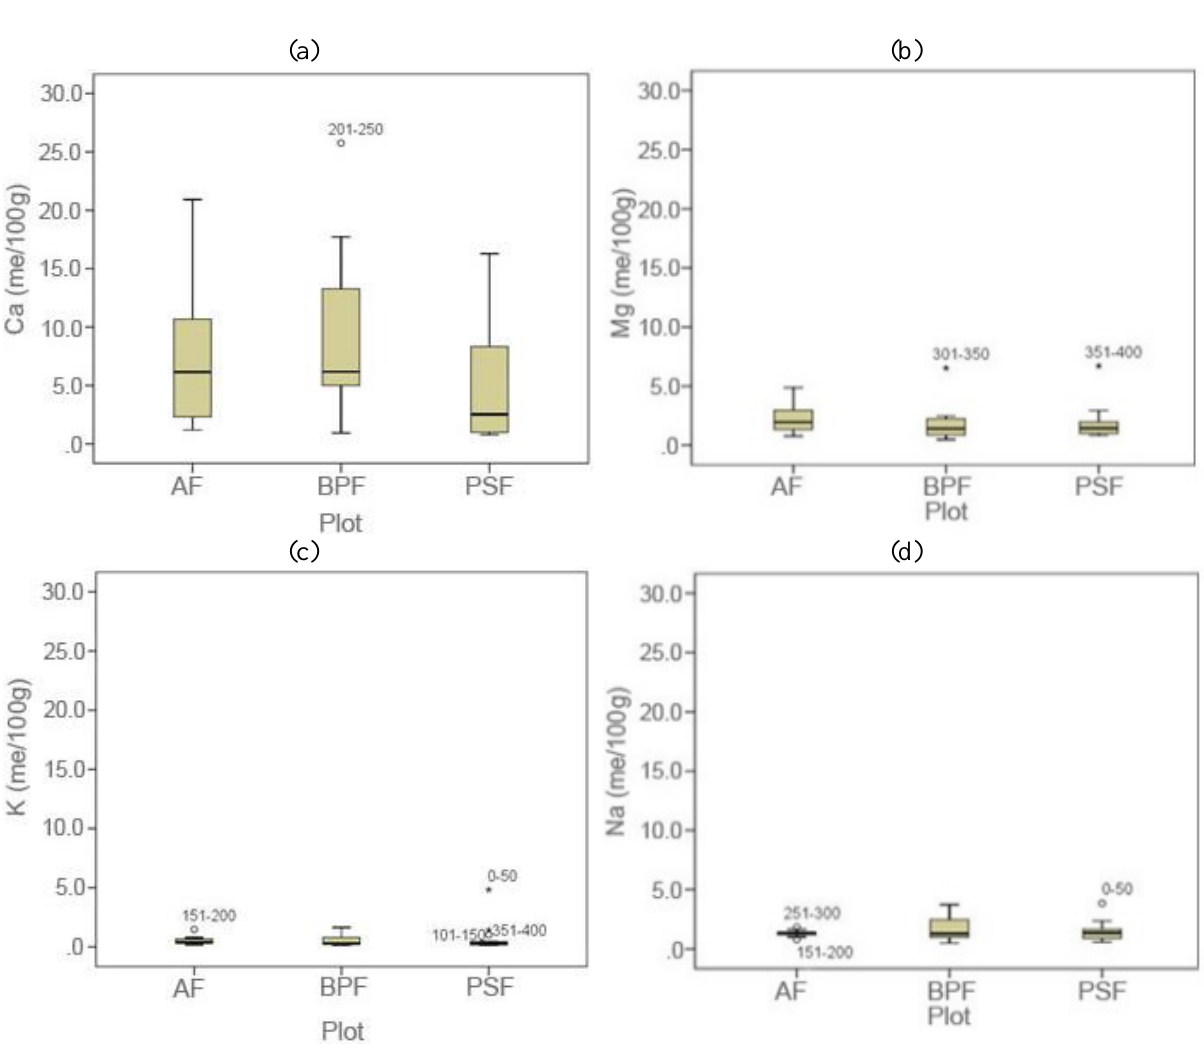
Figure 7. Soil macro nutrients of Ca, Mg, K, and Na from land cover types in Tumbang Nusa. The land cover types are: peat swamp forest (PSF; 2 plots), burnt peatland (BPF; 2 plots from peatland burned in 1997 and 2004), and agroforestry (AF; 3 plots with jelutung+rubber, jelutung+ N. lappaceum and jelutung+ Acacia , respectively). a) Ca, b) Mg, c) K, d) Na. Calcium has a wide range of values among land covers compared with other